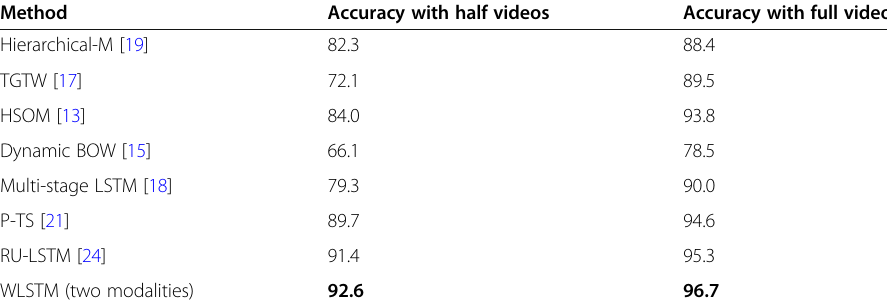
Table 6 Prediction accuracy comparison on UT-Interaction (%) Method